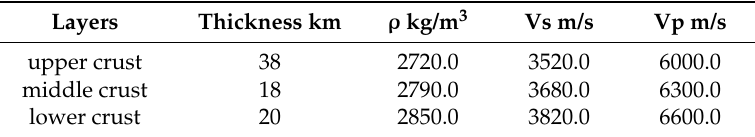
Table 3. Continental crust configuration from the Crust 1.0 model.